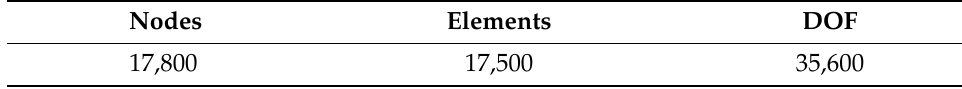
Table 6. Linear computation model mesh